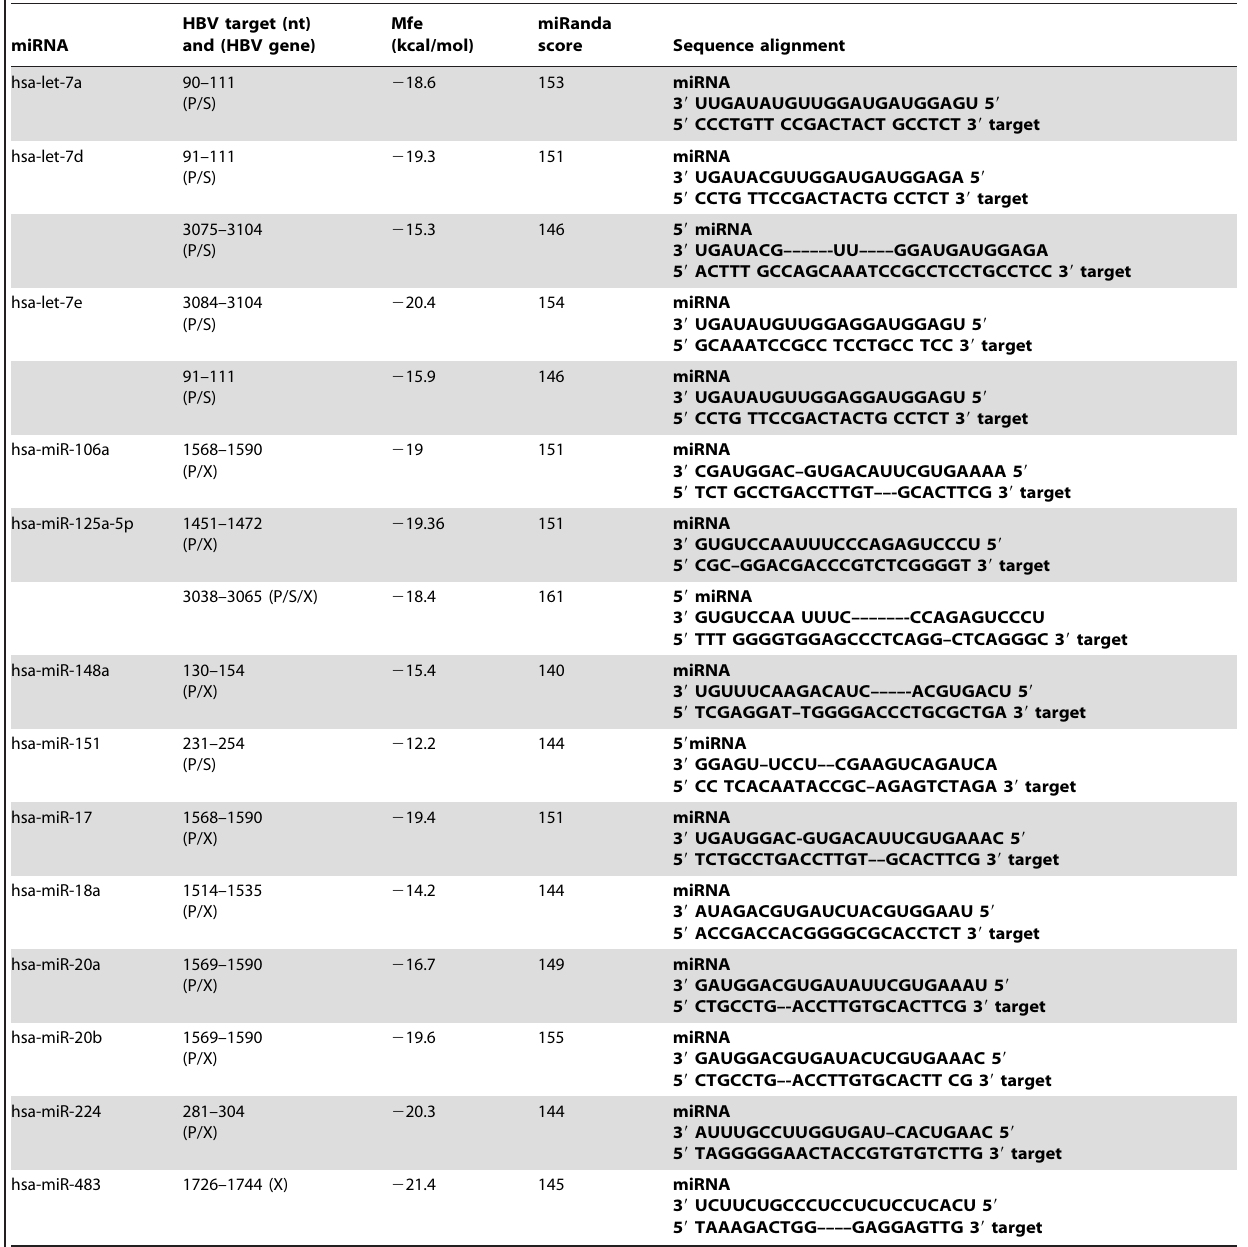
HBV target (nt) and (HBV gene)